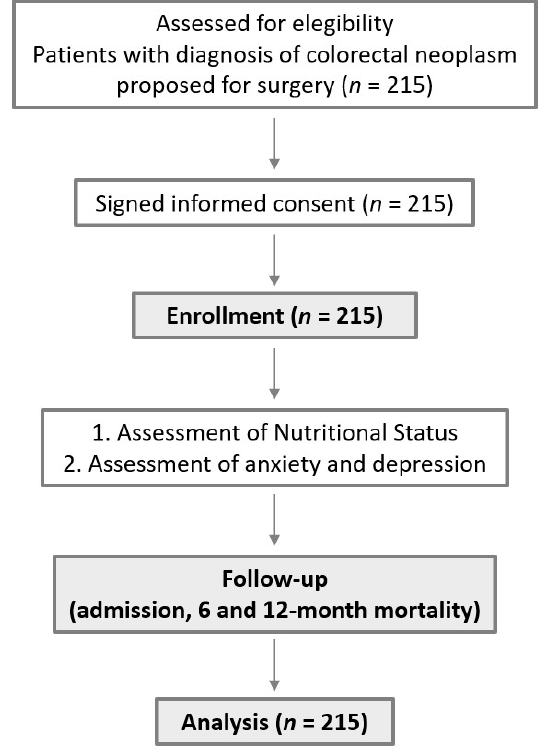
Figure 1. Study flow diagram.